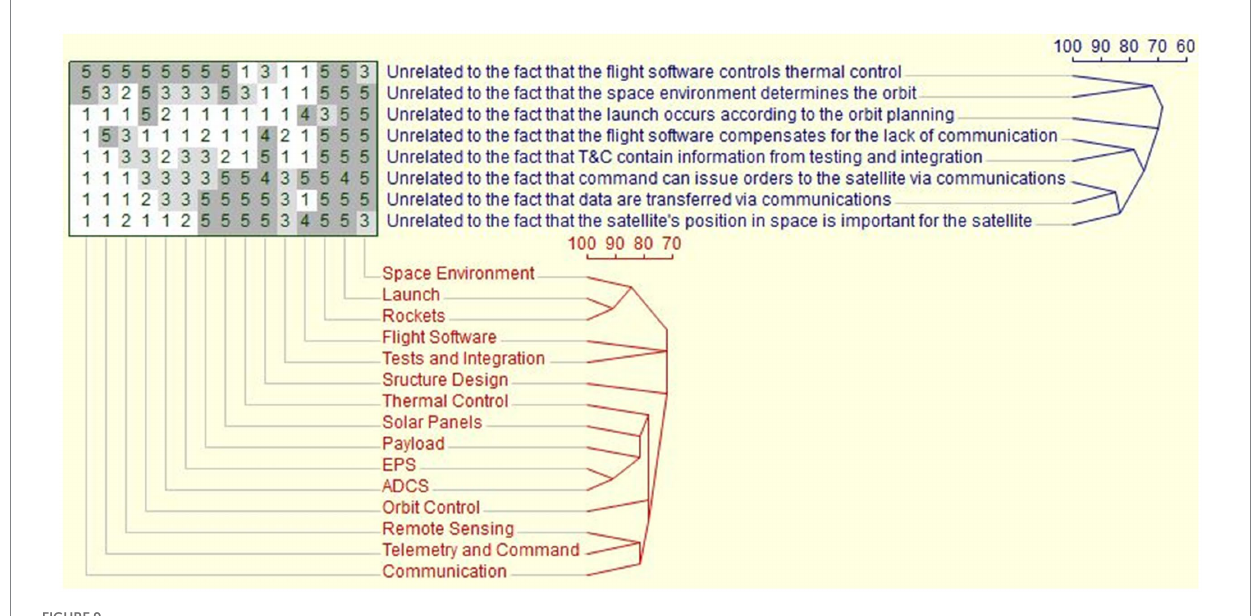
FIGURE 9 Sarah’s post repertory grid. The left side constructs are truncated for the sake of readability.